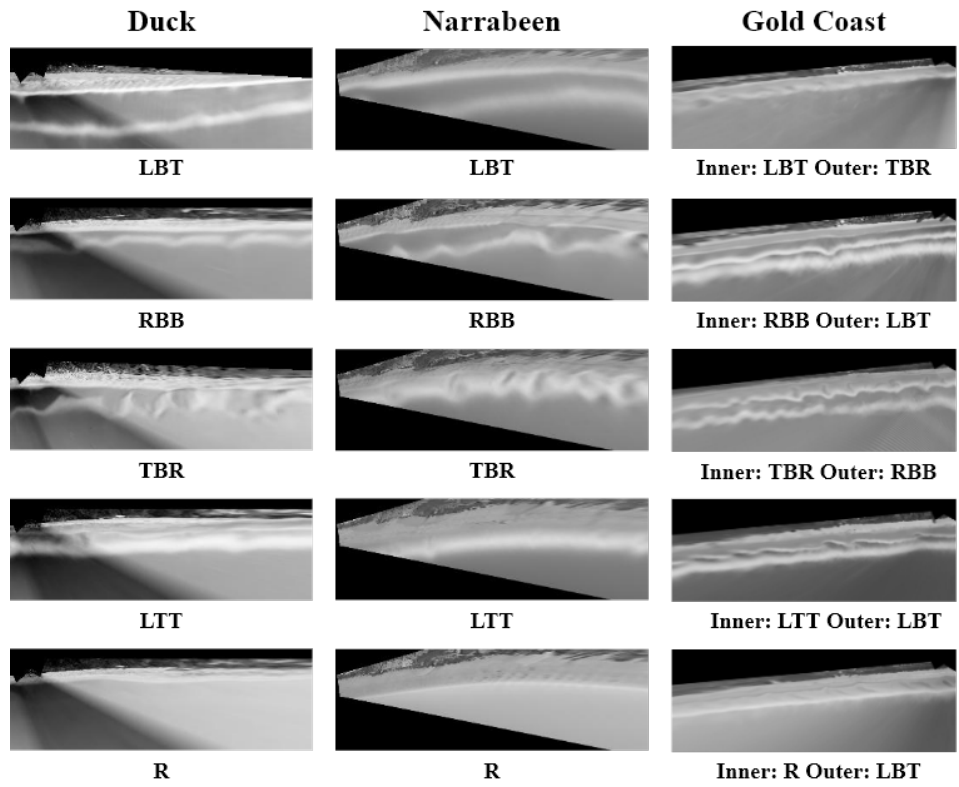
Figure 3. Examples of Argus imagery showing the five different beach states. Left column: Duck, middle column: Narrabeen and right column: Gold Coast. Note that the inner and outer bars of the Gold Coast have individual labels, with the outer bar labels only exhibiting the TBR, LBT and RBB